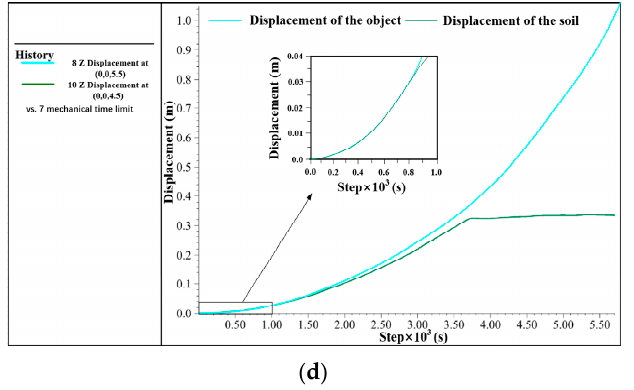
Figure 13. Initial stress field: ( a ) without gap phase; ( b ) transition phase; ( c ) with gap phase; and ( d ) the displacement curves of the object and bottom soil.